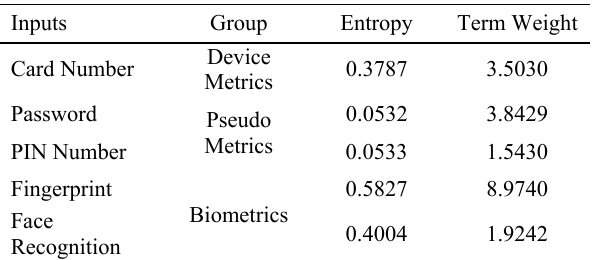
Table 1: Term weight and entropy input values for the artificial neural network.